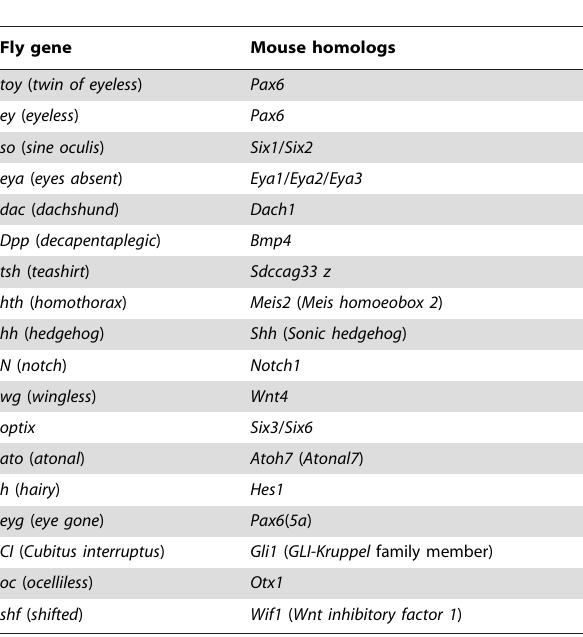
Table 1. Fly genes from the seed network and their putative mouse